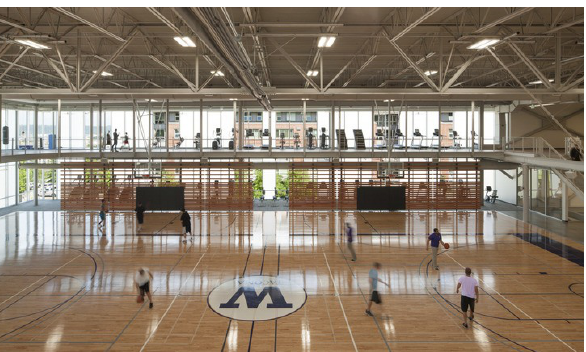
Figure 1. Photo of open gymnasium at YMCA at University of Washington that was used for range accuracy experiment as well as localization accuracy testing and characterization.